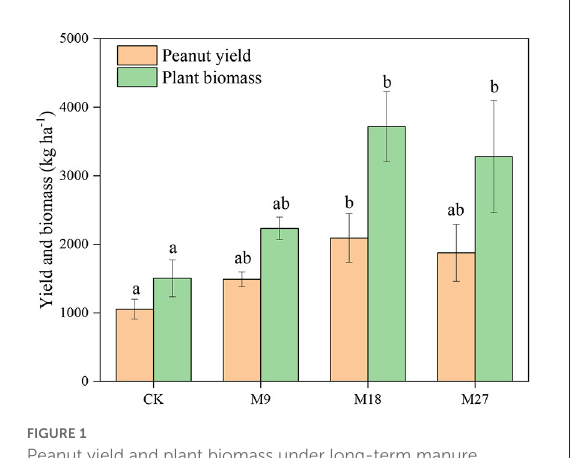
FIGURE1 Peanut yield and plant biomass under long-term manure application. Vertical bars represent standard error (n = 3). Different letters denote significant differences ( p < 0.05) between different